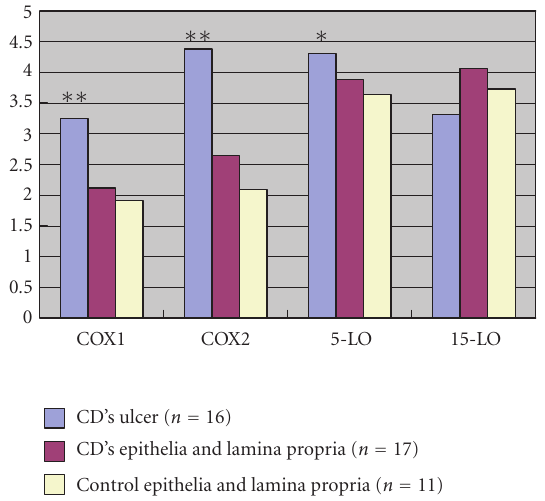
Figure 1: Expression grades for COX1, COX2, 5-LO, and 15-LO-1 in Crohn’s ulcer, Crohn’s epithelia, and lamina propria and control specimens. ( ∗∗ P < . 01 compared to control; ∗ P < . 05 compared to control).